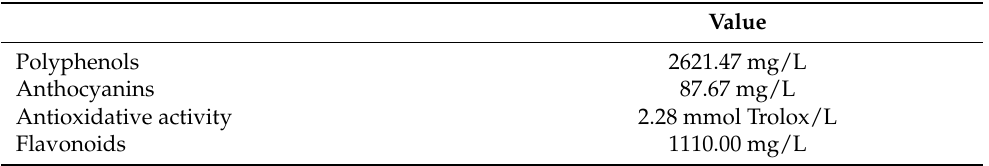
Table 4. Determined antioxidative activity, polyphenols, anthocyanins and flavonoids content in the best-chosen beverage, Munich malt beverage with 30% of chokeberry juice.